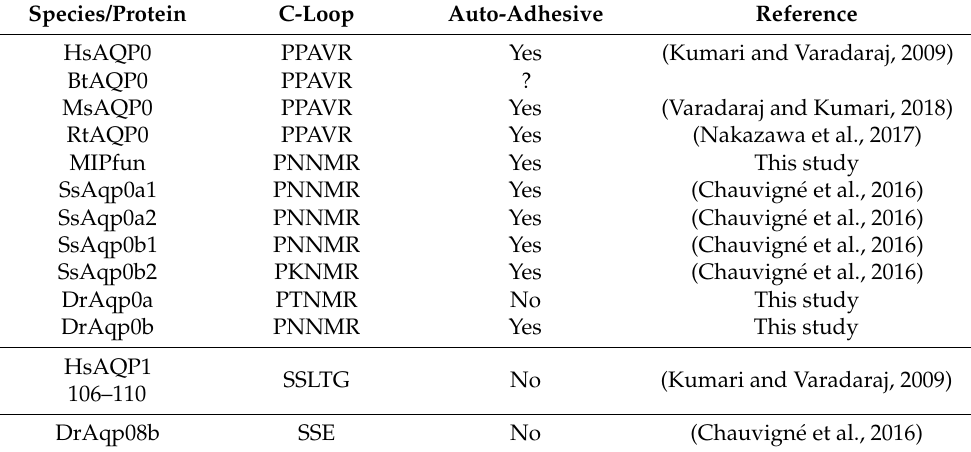
Table 1. Summary of key C-loop amino acids (110–113) and self-adhesive properties of AQP0 from different species. Hs, Homo sapiens ; Bt, Bos taurus ; Ms, Mus musculus; Rt, Rattus norvegicus; MIPfun, Fundulus heteroclitus ; Dr, Danio rerio ; Ss, Salmo salar . Species/Protein C-Loop Auto-Adhesive Reference HsAQP0